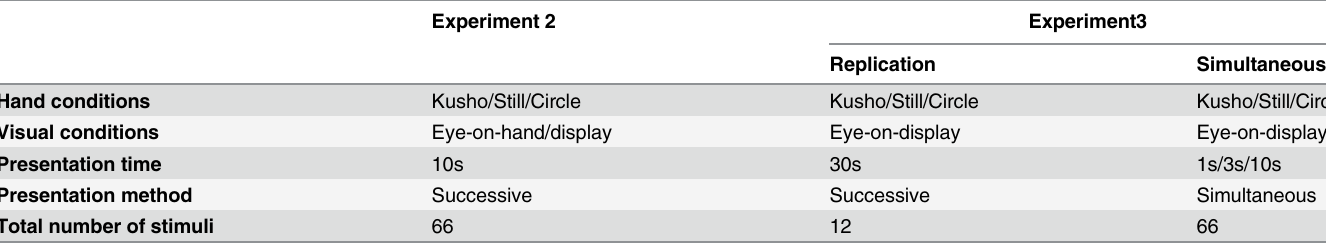
Table 1. Differences in design of the construction tasks in Experiments 2 and